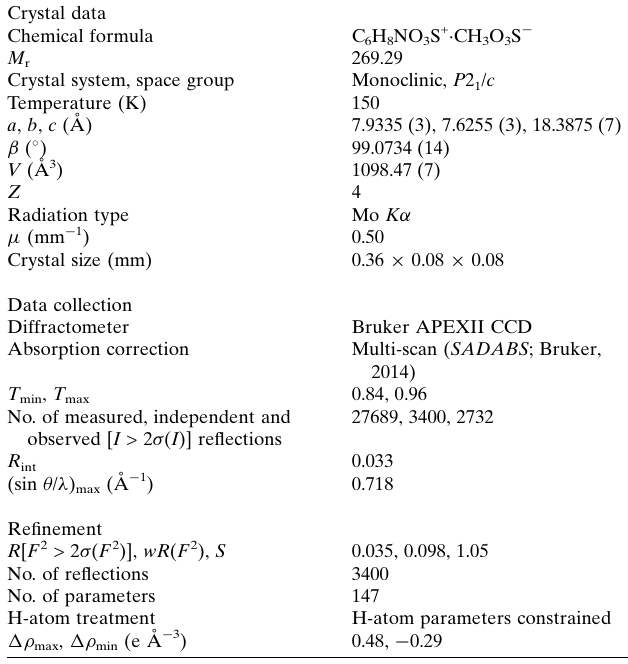
Table 2 Experimental details. Crystal data Chemical formula